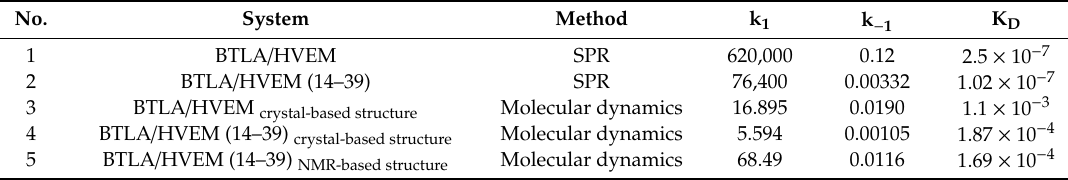
Figure 7. HVEM (14–39) peptide blocks BTLA/HVEM binding. 293T cells expressing human BTLA were incubated with peptides (5 mg/mL) prior to labeling with HVEM-Fc and AF647-conjugated anti- human IgG antibody. The blocking capacity of the HVEM (14–39) peptide was first compared to ( A ) a scrambled (Ac-SECGRCEAPEKTKSLCVTPEPVGCYG-NH 2 ) peptide or ( B ) to variant peptides (Table S2). The graph shows the geometric fluorescence intensity (GMFI). * p < 0.05, ** p < 0.01, *** p < 0.001 and **** p < 0.0001 following one-way ANOVA and Dunn’s post-test, compared to the HVEM- Fc condition in A and HVEM-Fc or native peptide in B.